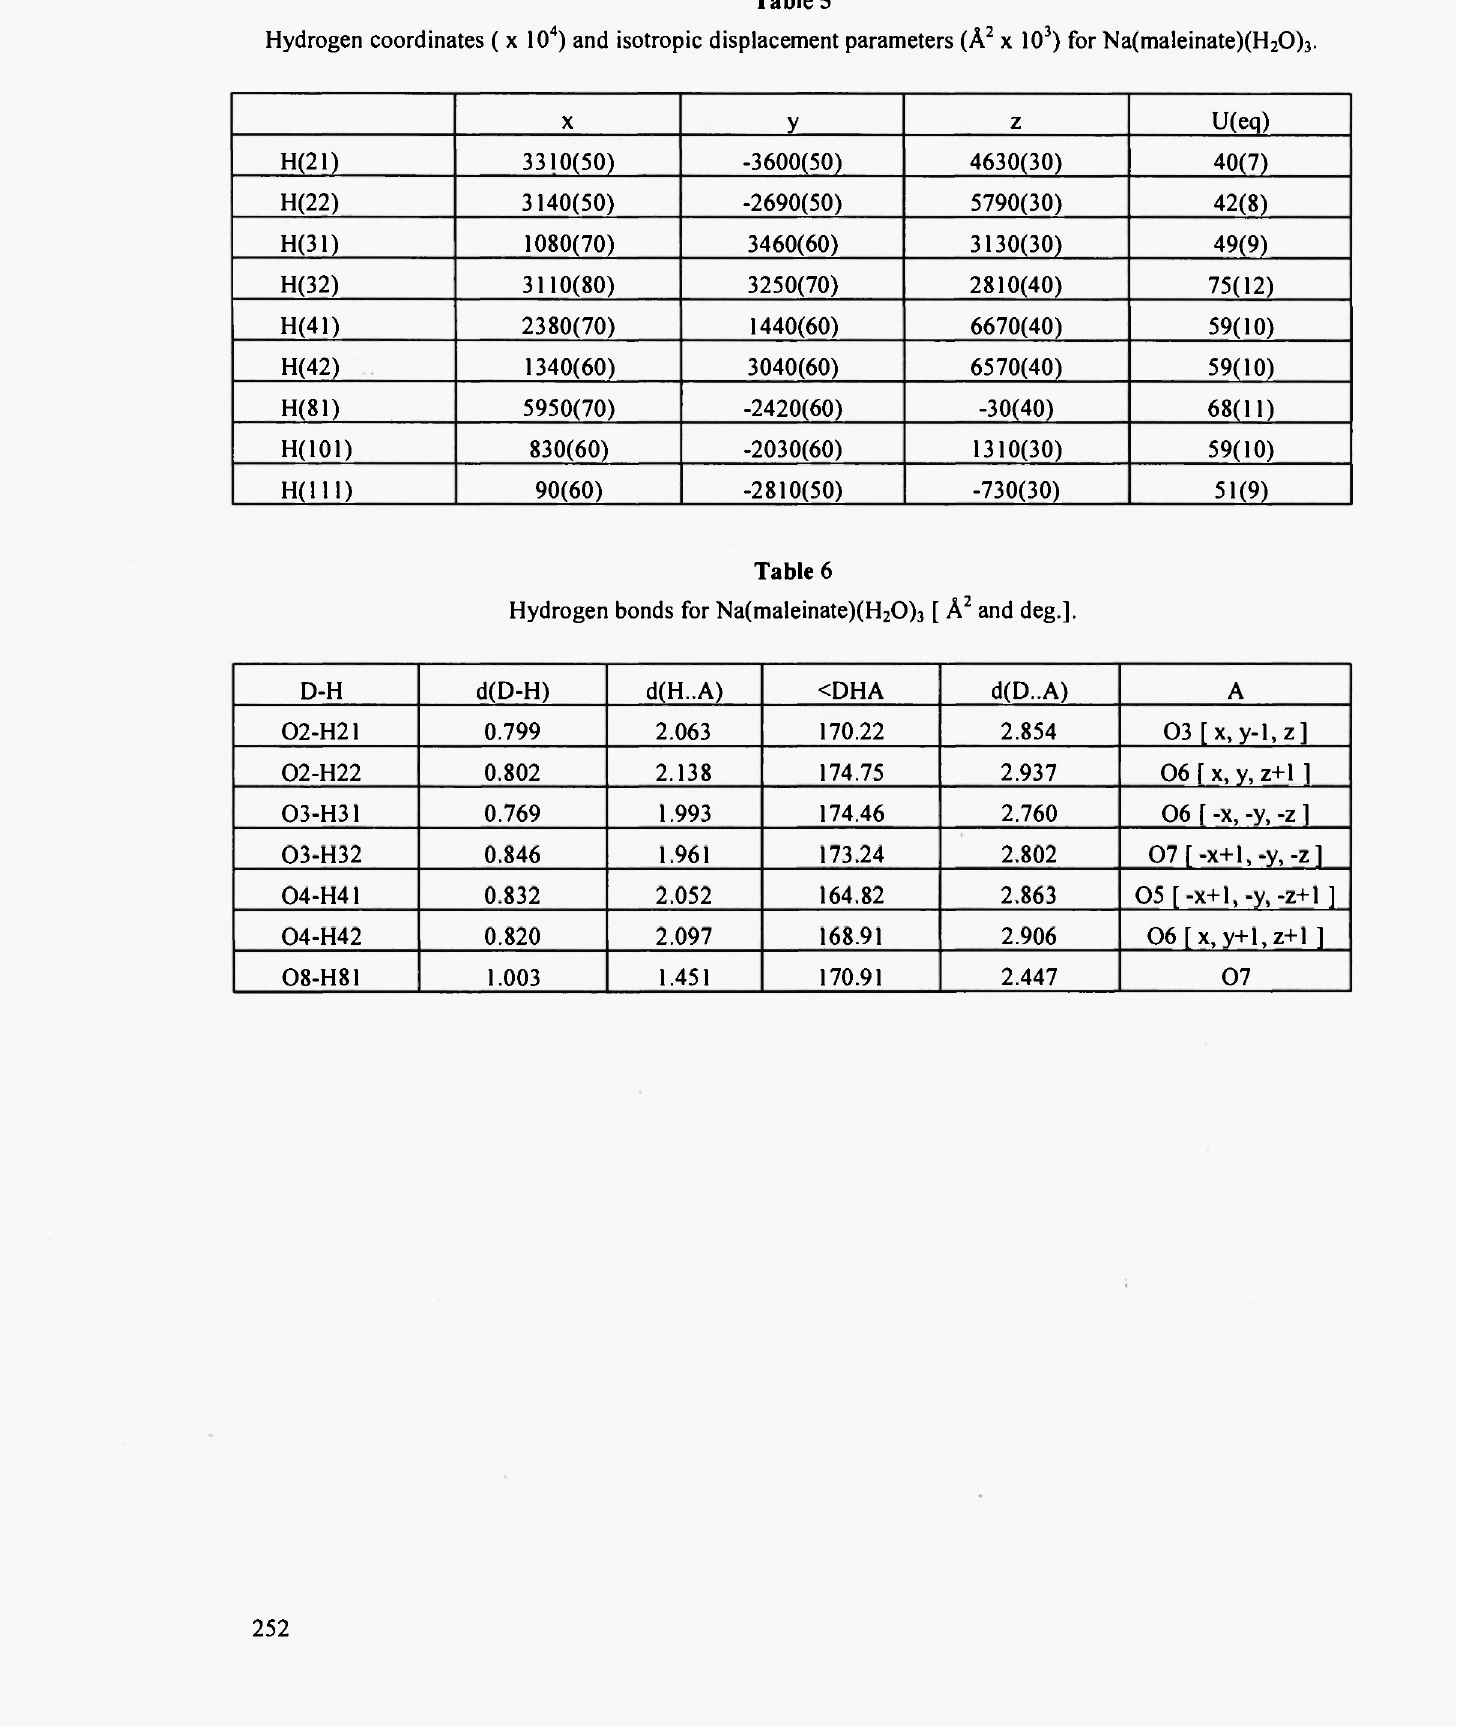
Hydrogen bonds for Na(maleinate)(H 2 0) 3 [ A 2 and